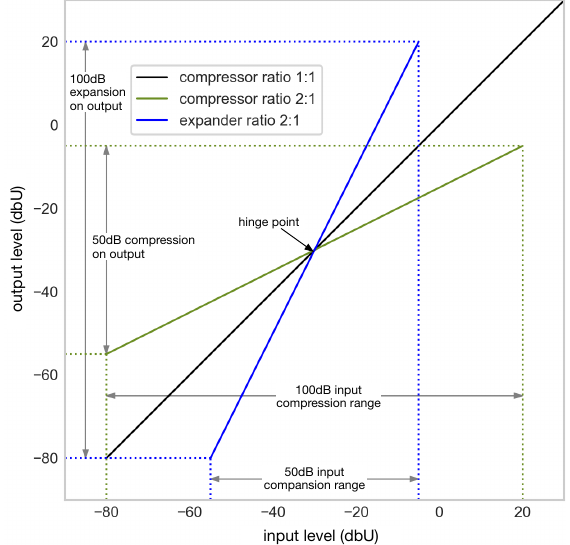
Figure 7. Compressor/expander with hinge